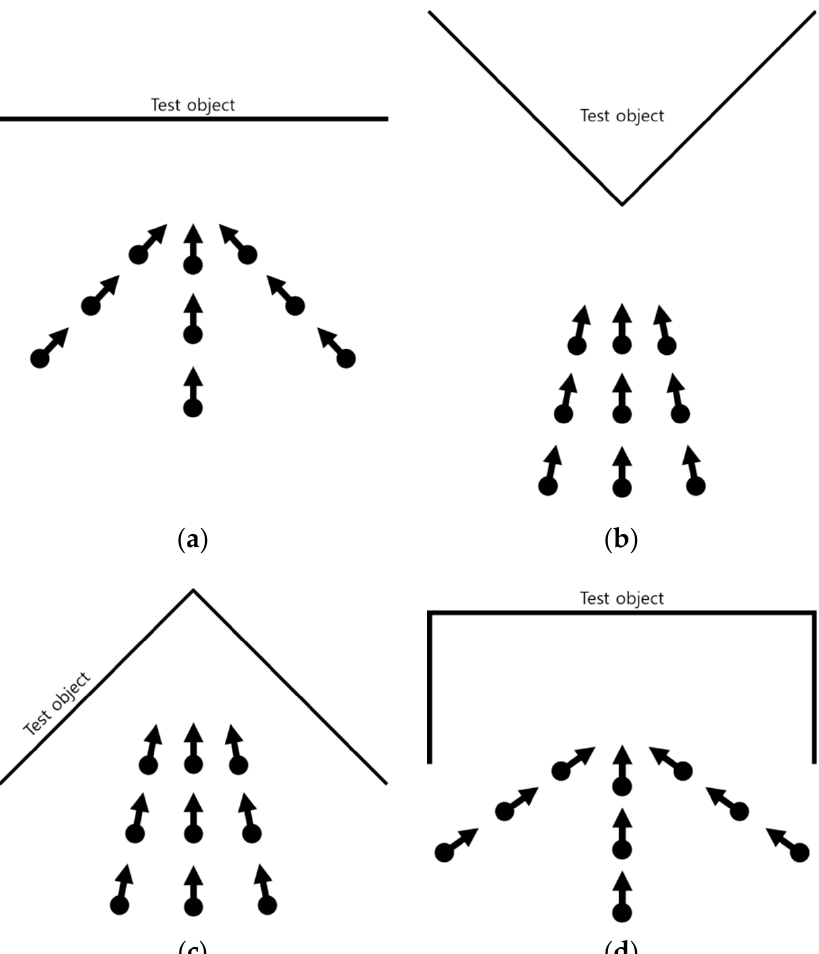
Figure 5. Configuration of image acquisition according to different test object types: ( a ) Plane-, ( b ) V-, ( c ) A-, and ( d ) Room-type.